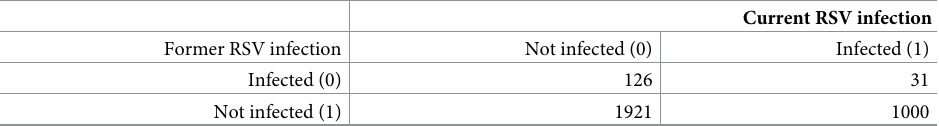
Table 1. Former and current RSV